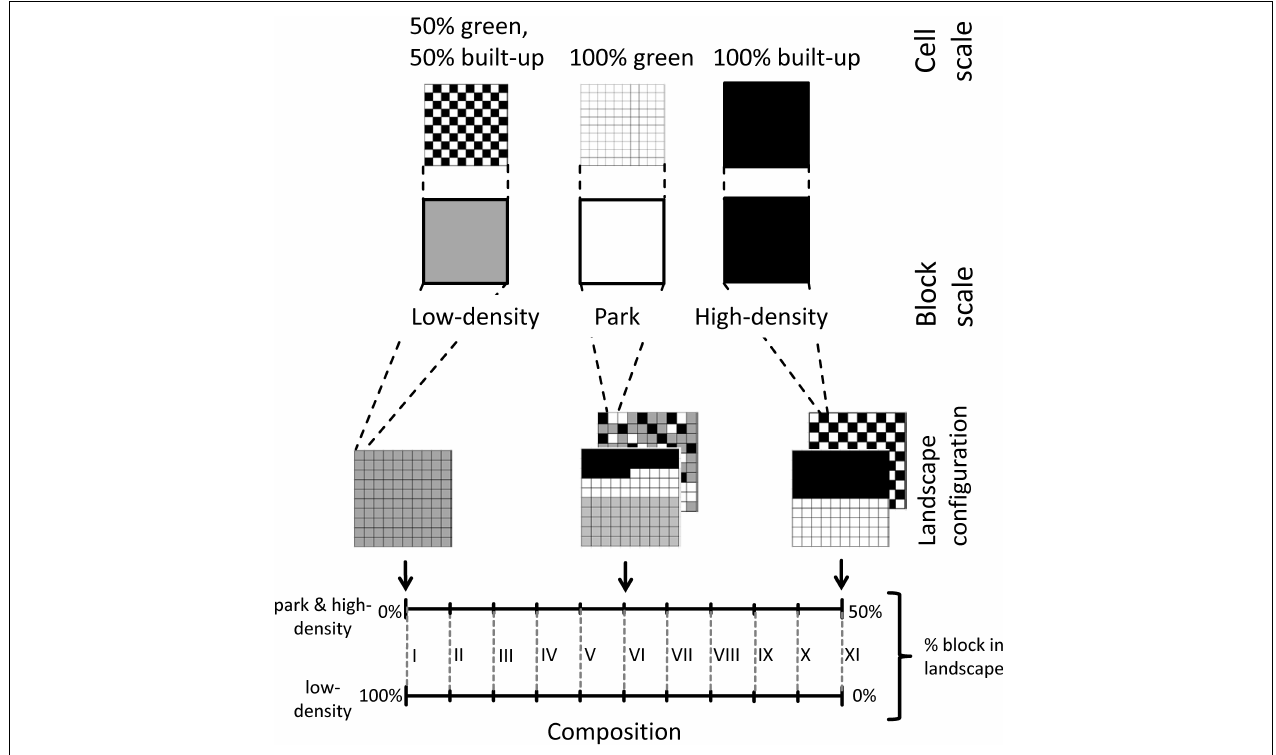
FIGURE 2 | Schematic representation of the virtual city landscape with the translation from cell to block scale (above) and 11 composition settings I to XI and examples of landscape configurations (below) .